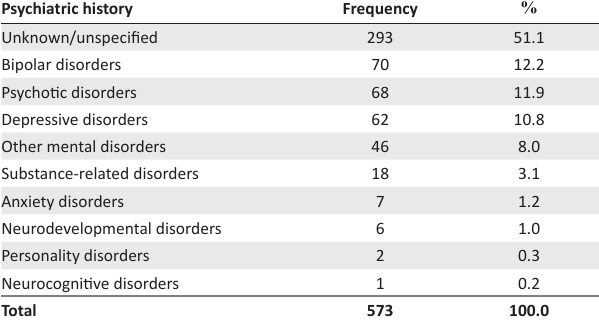
TABLE 1: Psychiatric history prior to arrest ( n =